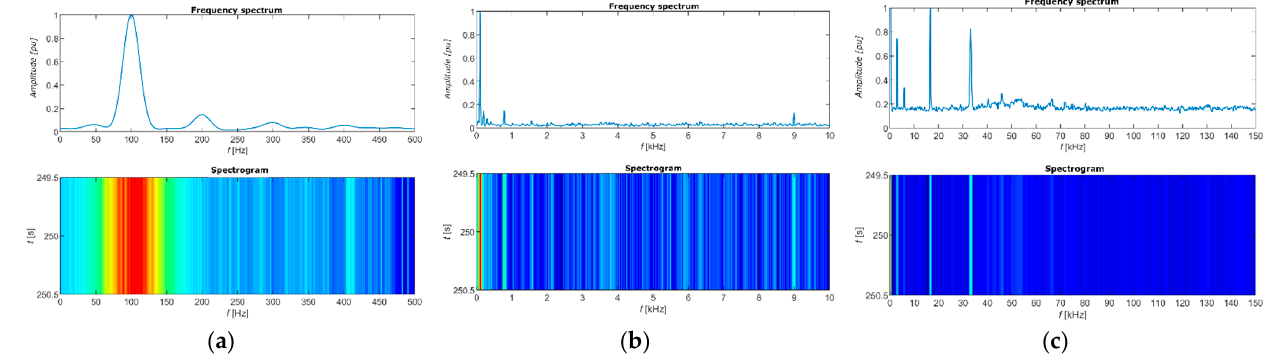
Figure 19. Signal analysis in the frequency domain: ( a ) Frequency range up to 500 Hz; ( b ) Frequency range up to 10 kHz; ( c ) Frequency range up to 150 kHz.